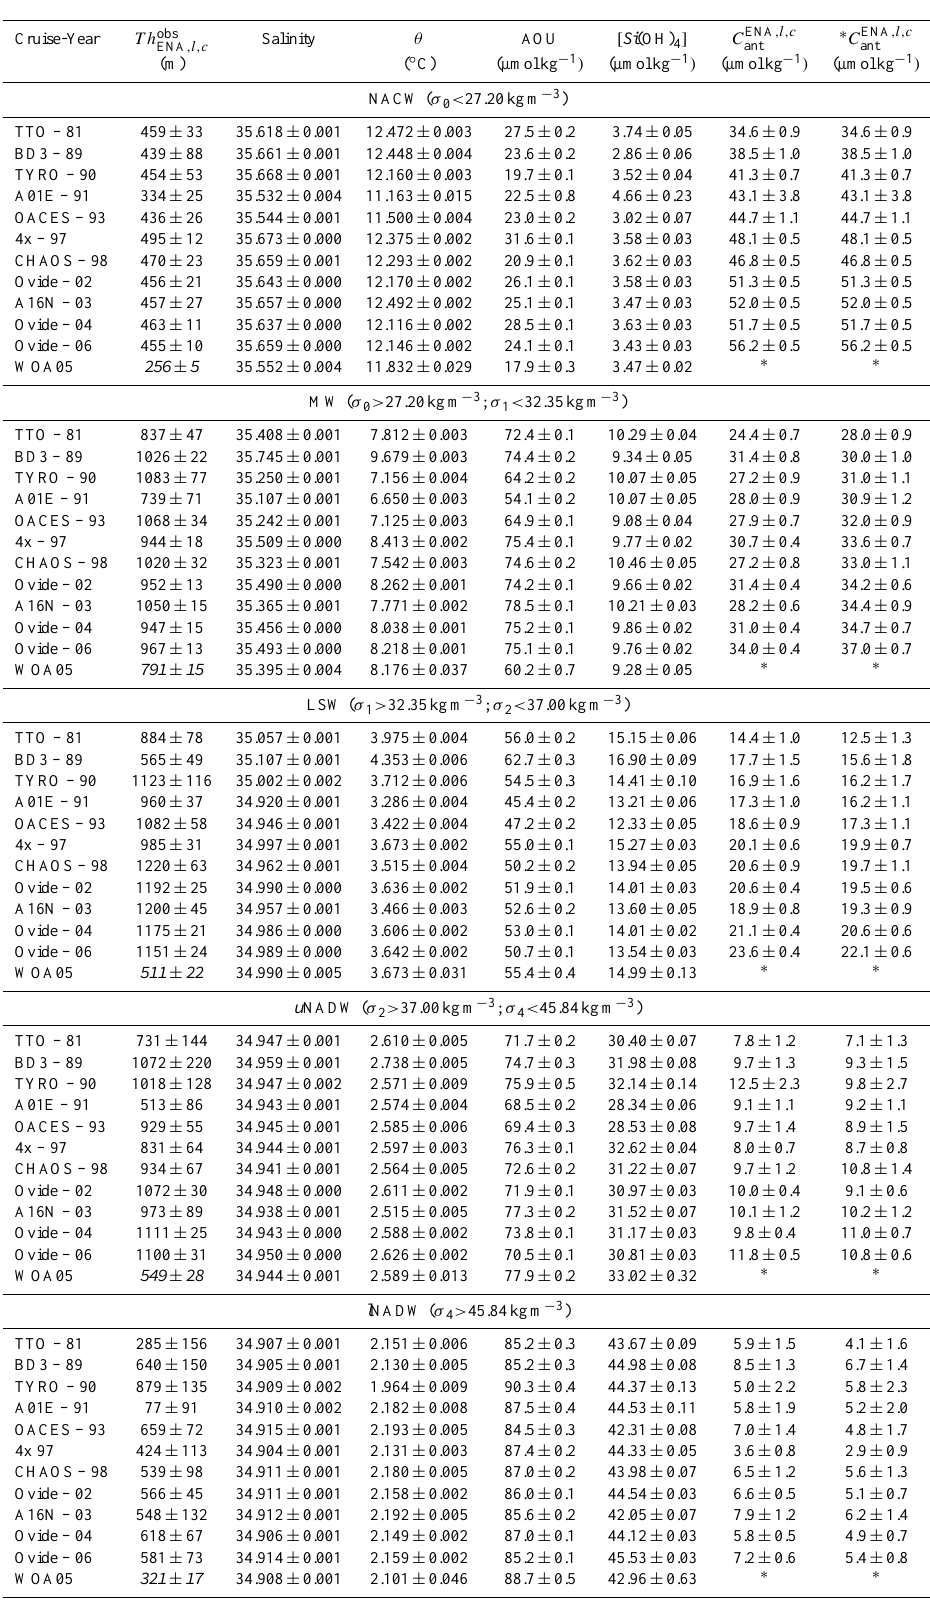
Table 2c. Eastern North Atlantic